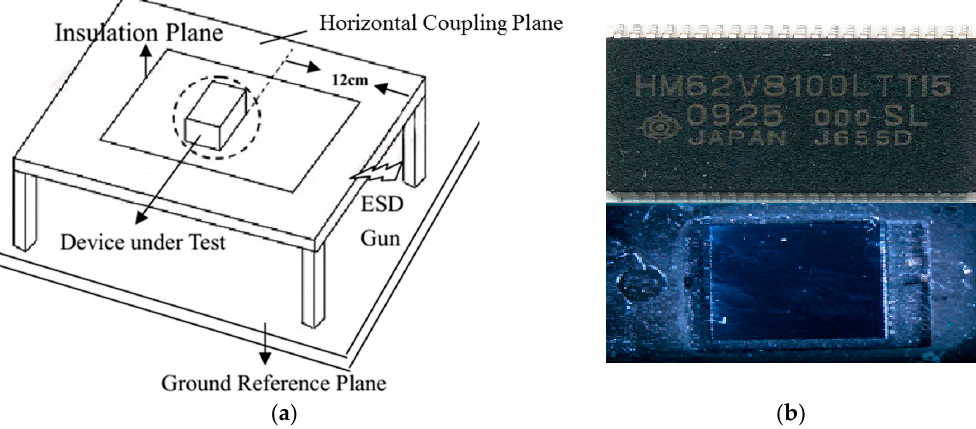
Figure 8. The schematic diagram of the electrostatic discharge (ESD) test system ( a ) and the photomicrograph of the polished chip ( b ).